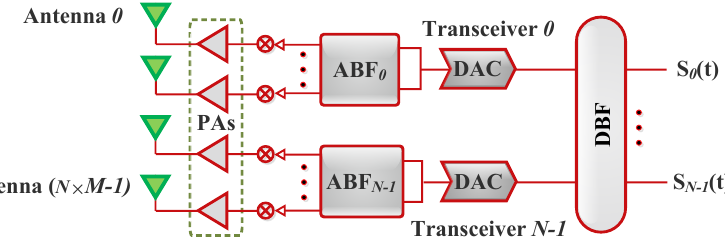
Figure 18. HBF architecture for mm-wave MIMO system.